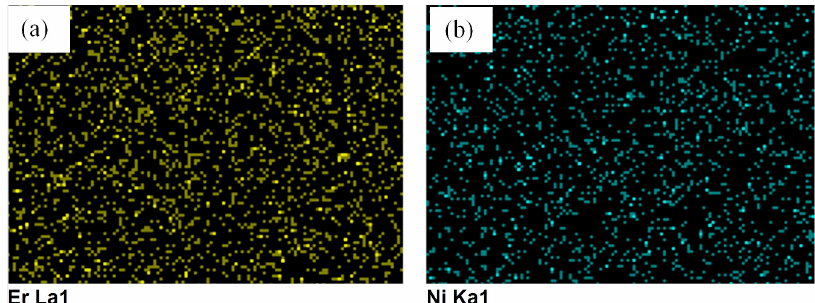
Figure 5. Metal mapping ( a ) Er 3+ /TiO 2 and ( b ) Ni 2+ /TiO 2 .